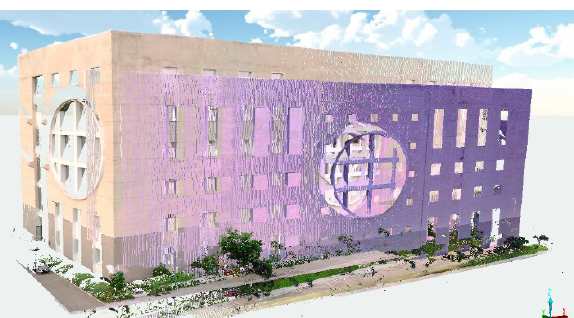
Figure 7. Layout of Academic building 2.